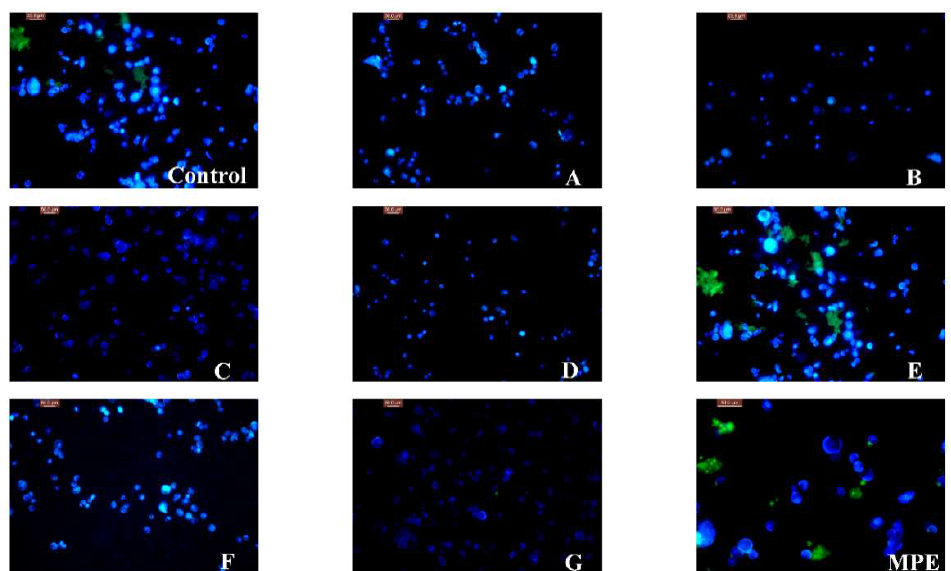
Figure 3. Fluorescence microscopy of A549 cell line treated with MPE, MPPs and oleanolic acid. (Control–untreated, A –vanillic aldehyde, B –caffeic acid, C –oleanolic acid, D –chlorogenic acid, E –gallic acid, F –procyanidin B 2 , G –5-fluorouracil, MPE–mango peel extract).